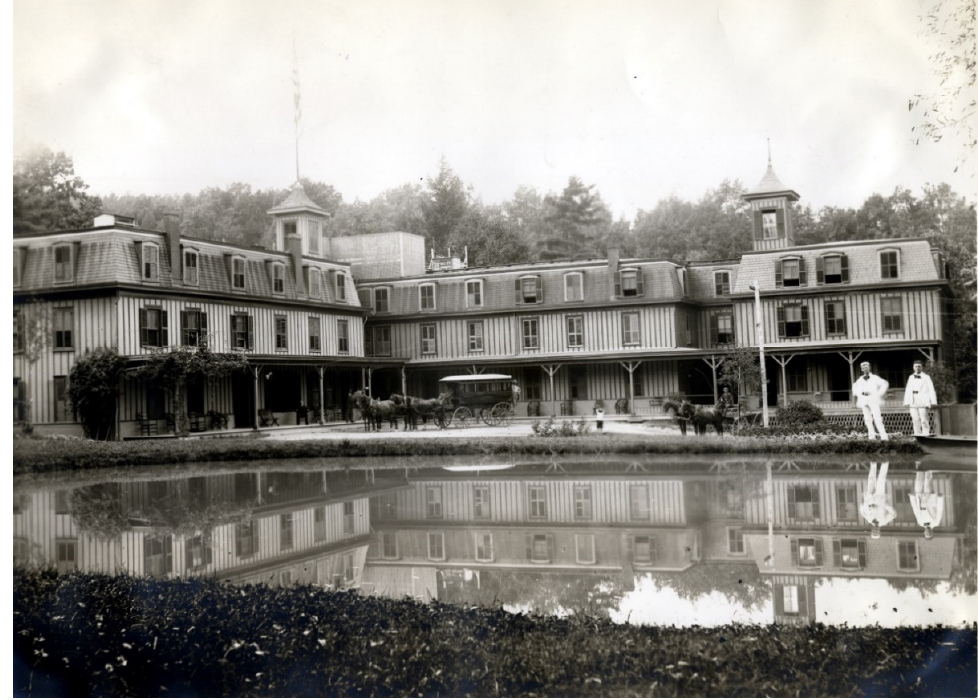
Figure 8. The Glen Mountain House, ca. 1880. Photo used with permission: NY State Office of Parks, Recreation & Historic Preservation; parks.ny.gov (accessed on 12 June